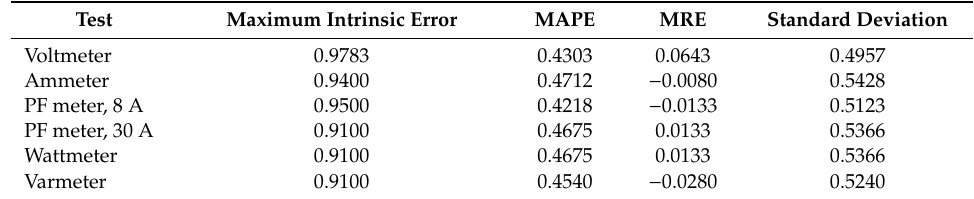
Figure 12. Varmeter test: ( a ) OSPPSM vs. RMS reactive power. ( b ) Intrinsic error of reactive power measuring. Table 4. Intrinsic value test: maximum intrinsic error (%), MAPE (%), MRE (%) , and standard deviation